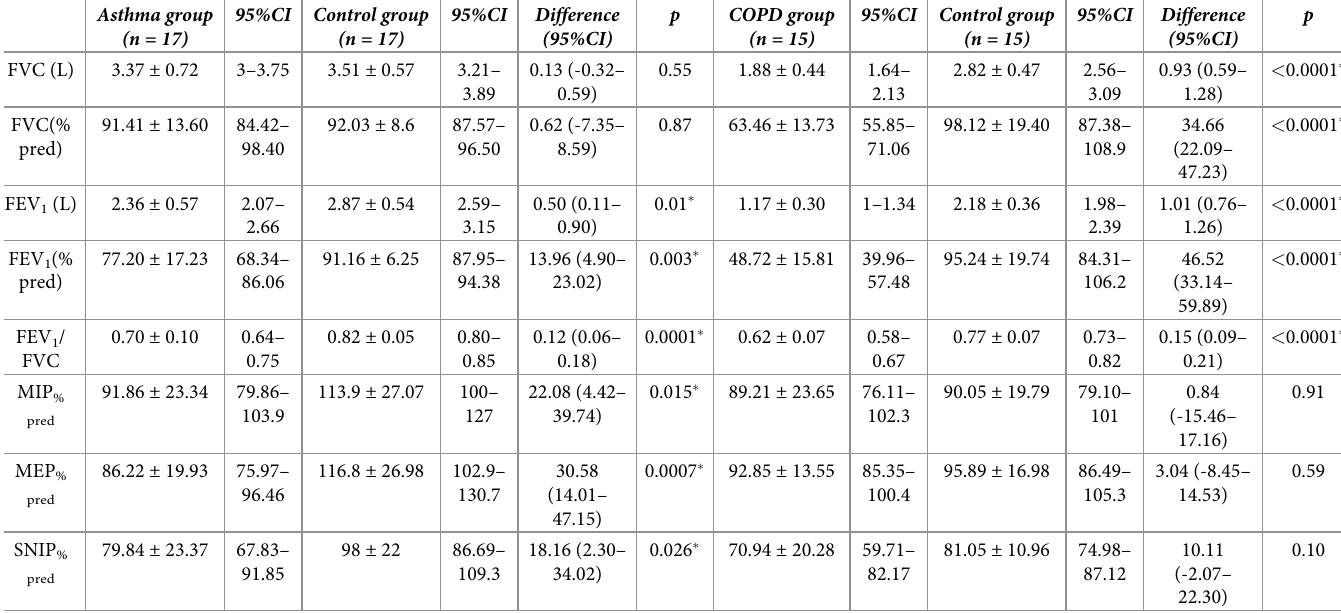
Table 2. Pulmonary function data of the sample. Asthma group (n = 17)